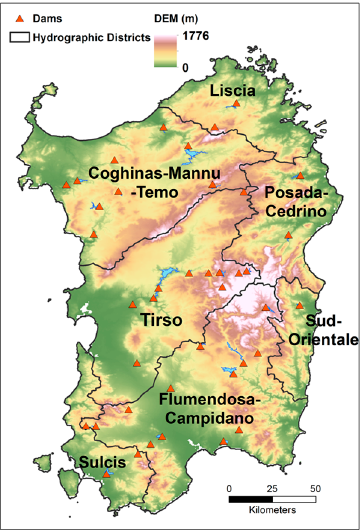
Figure 1. Map of Sardinia, showing the seven hydrological districts and the locations of the reservoirs